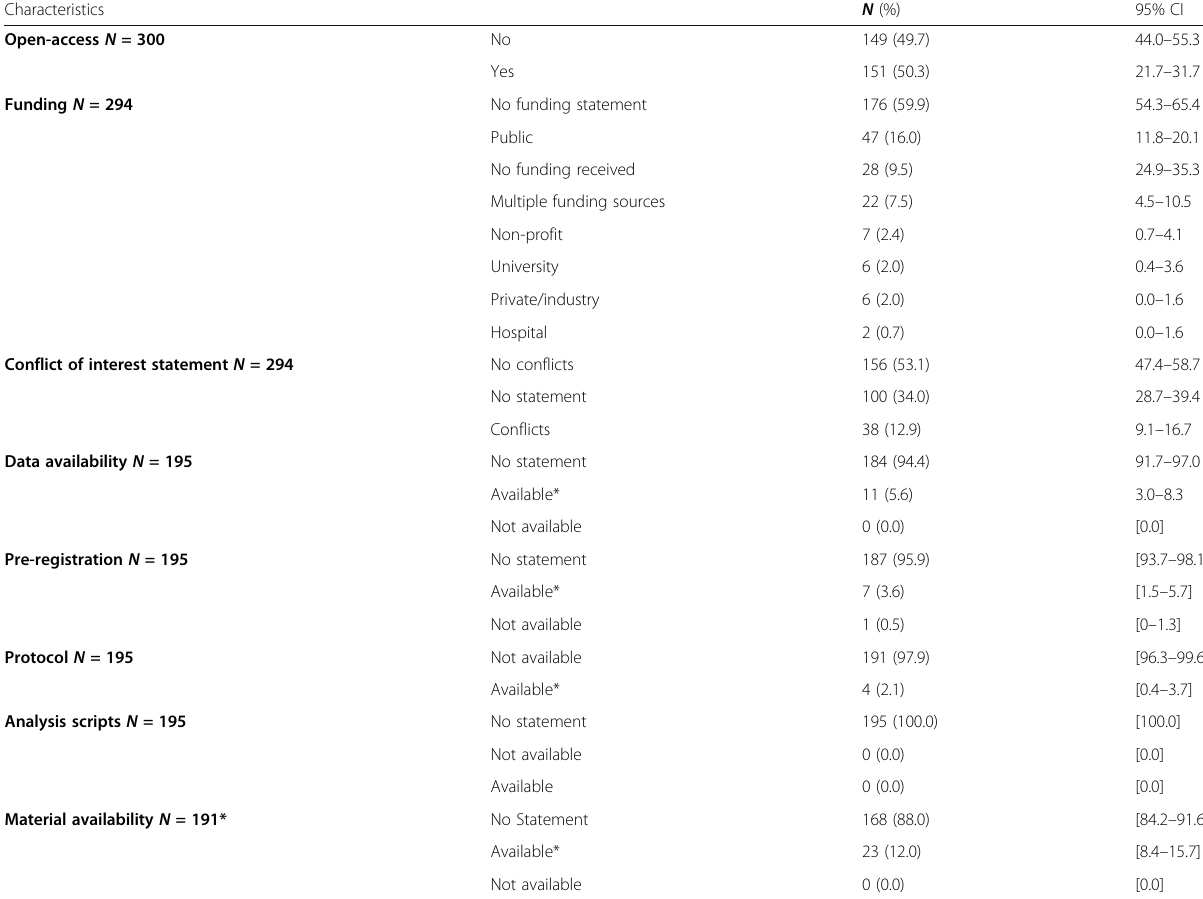
Table 3 Reproducibility-related characteristics of included publications